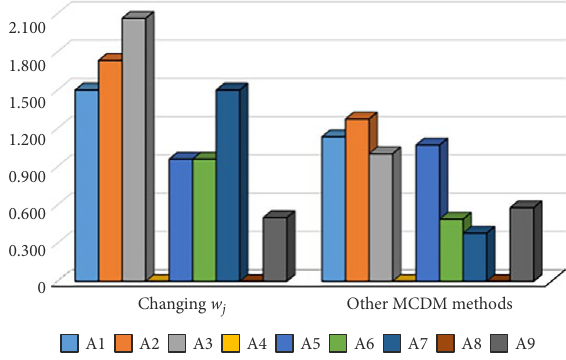
Figure 6. STDEV of the ranks through the